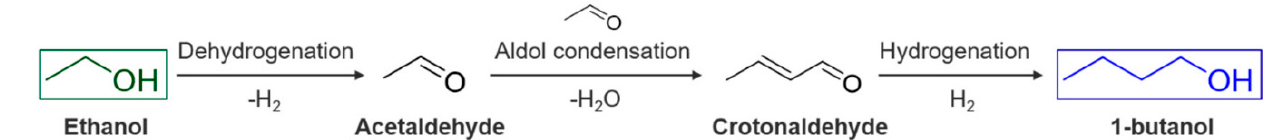
Figure 1. Representative reaction pathway for the conversion of ethanol to n-butanol via aldol condensation. Reprinted from Xi et al. [28] and licensed under CC BY 4.0.